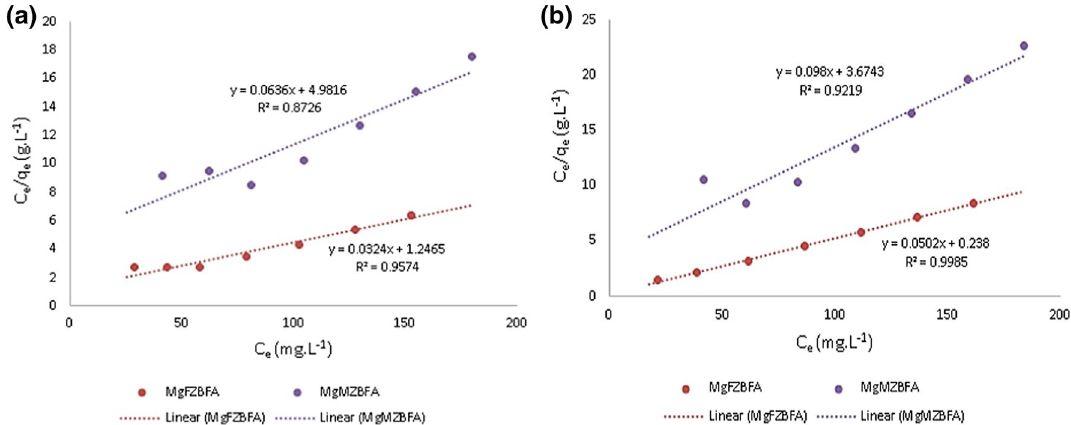
Fig. 14 Langmuir isotherm plots for the sorption of a PNAN, b NB on MgFZBFA and